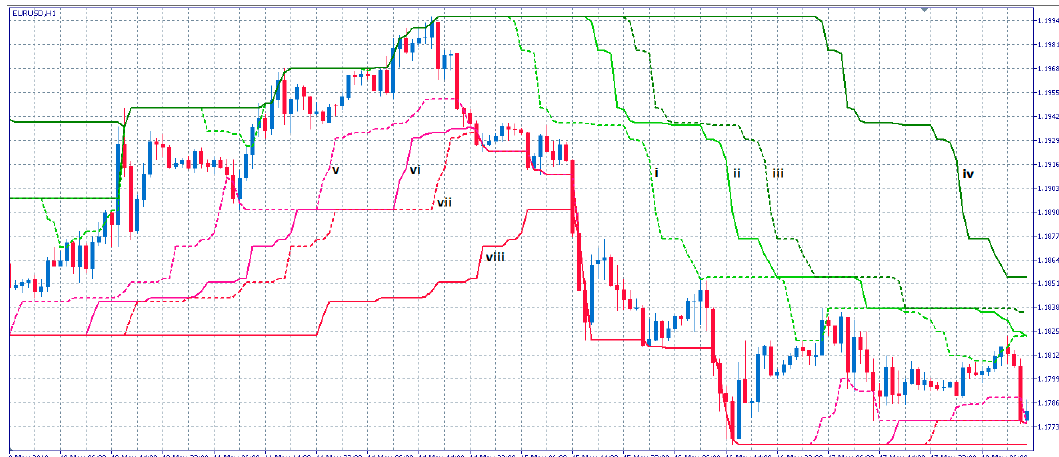
Figure 2. The lines used by the Turtle indicator as described above, on a EURUSD chart with x = 24, y = 60 and n = m =